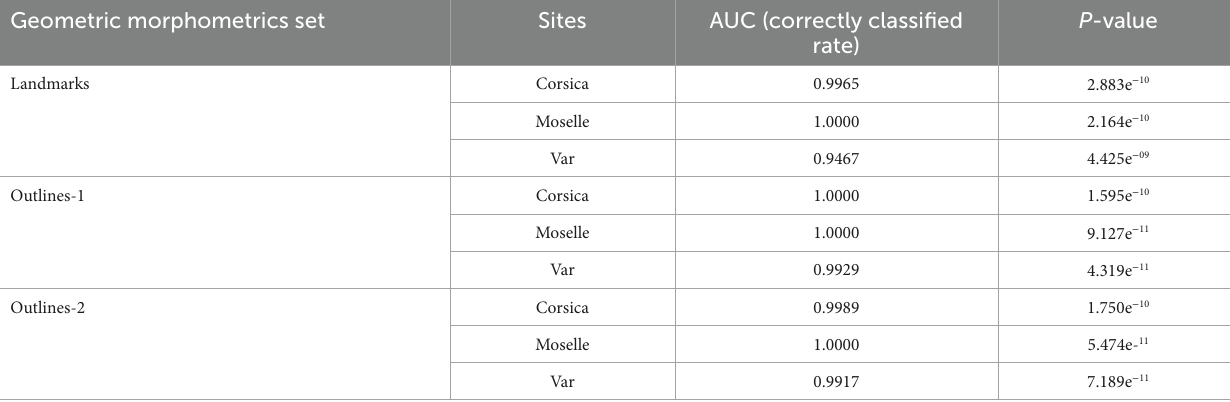
P-value for landmarks, outlines-1 and